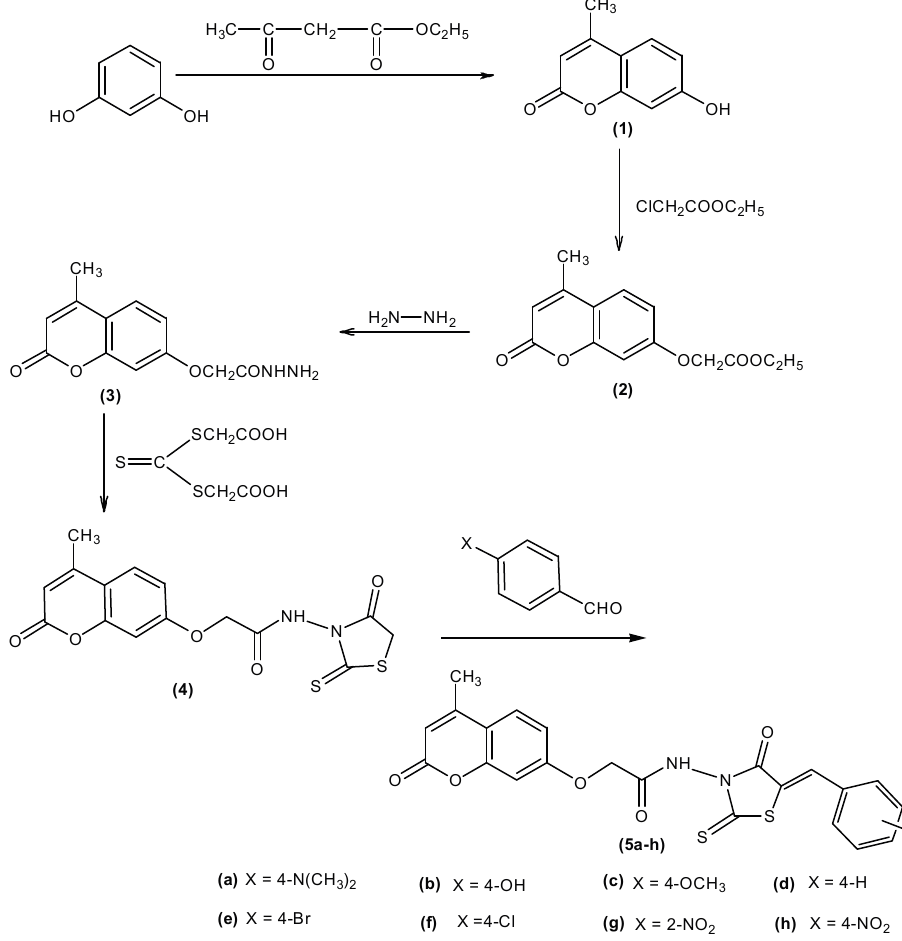
Scheme 1. Synthetic route for the preparation of compounds 5a – h